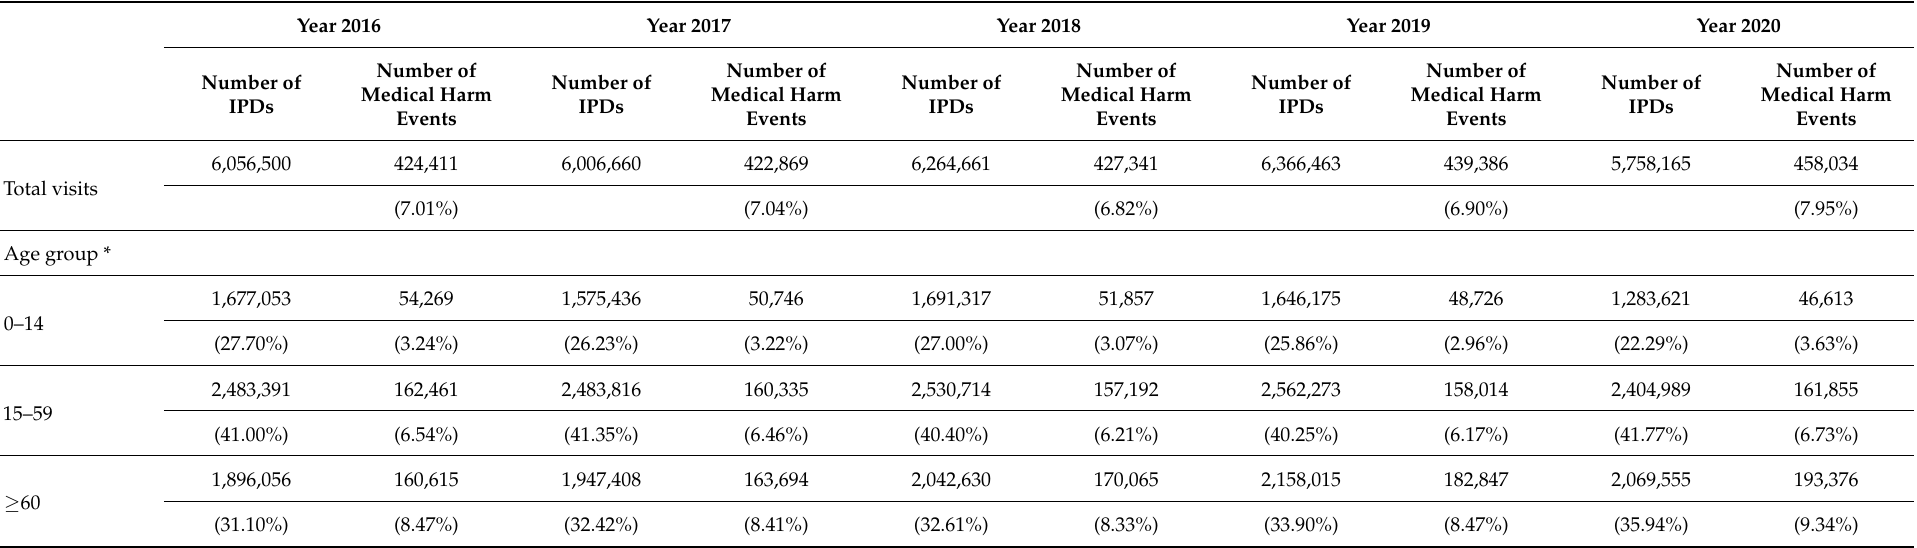
Table 2. Number of medical harm events in each